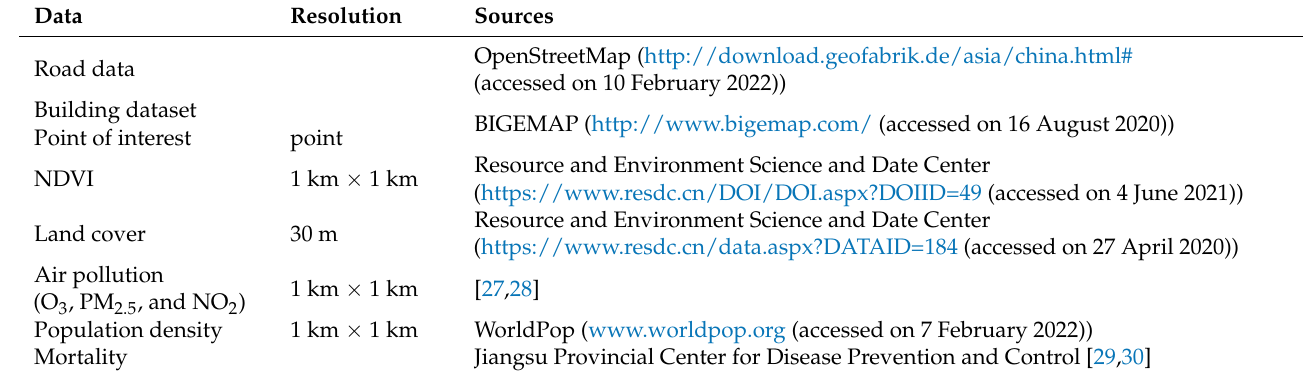
Figure 1. Location of the study area. Table 1. Date, resolution, and